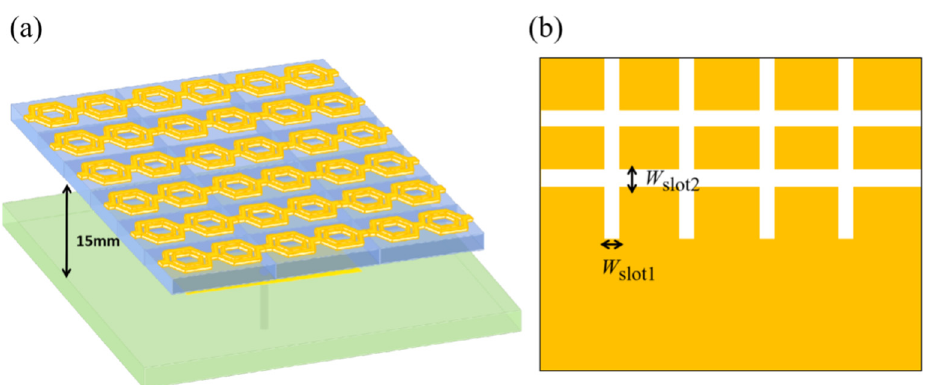
Figure 6. Nested double-hexagon ring-shaped metamaterial slot microstrip antenna ( a ) Three-di- mensional view; ( b ) Schematic diagram of etched slots of the ground plate.